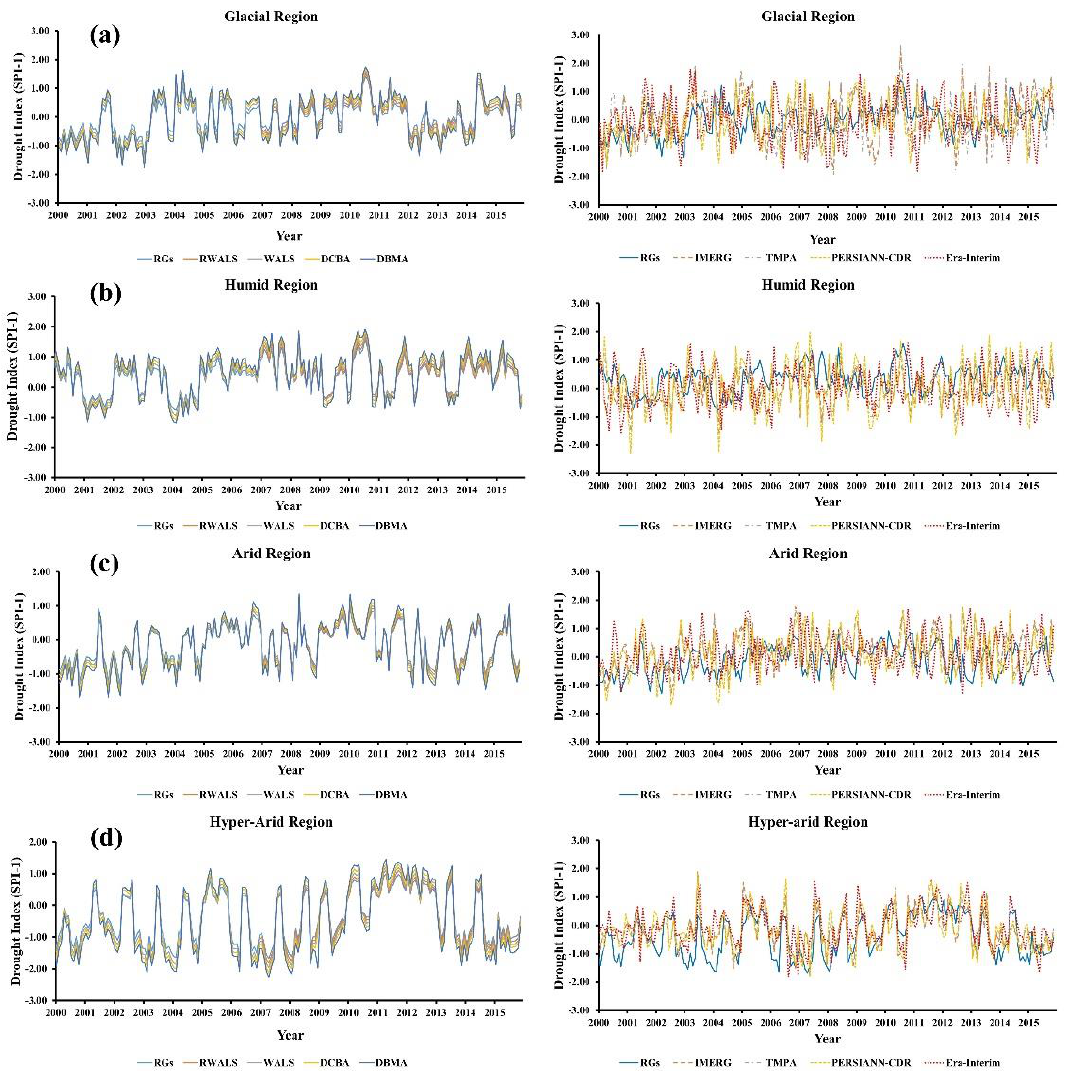
Figure 7. ( a – d ) SPI-1 drought index estimated using RGs and MSPDs ( left panel ) and SPDs ( right panel ) across all four climate regions.